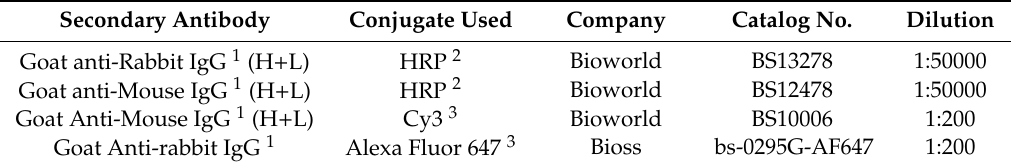
Table 5. Secondary antibody used in the